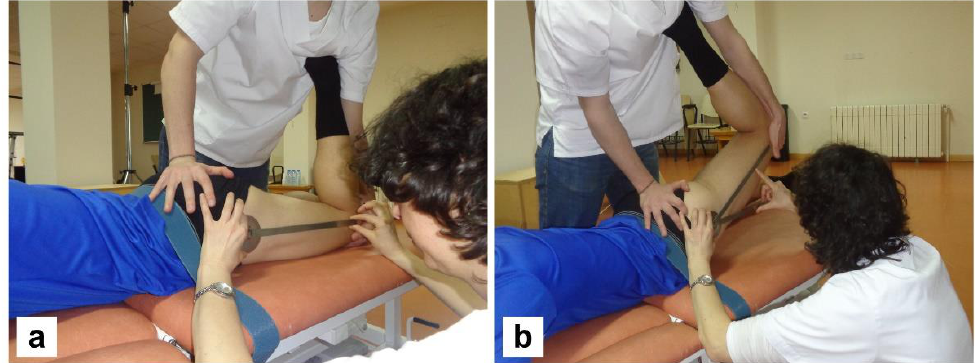
Figure 5. Start ( a ) and end ( b ) positions of the quadriceps extensibility test, performed in the prone position.